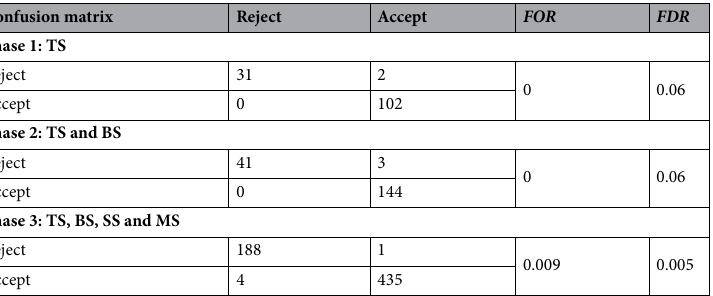
Table 7. Pre-trained DenseNet161 confusion matrices (rows and columns corresponding to predicted and actual classes, respectively), along with the false omission rate ( FOR ) and the false discovery rate ( FDR ), for the different phases of the testing (TS, BS, SS and MS correspond to top, bottom, side and middle sealing, respectively).